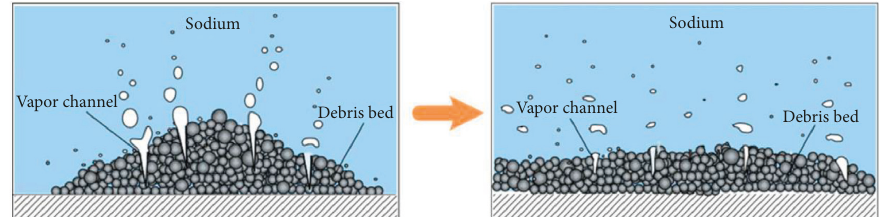
Figure 2: Debris bed self-leveling